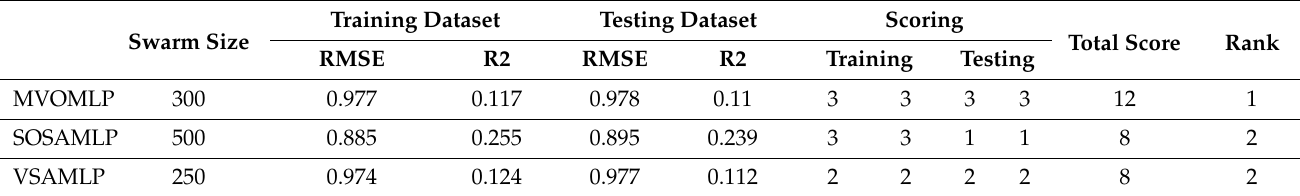
Table 4. Selection of the best fit structures among the most accurate items of each